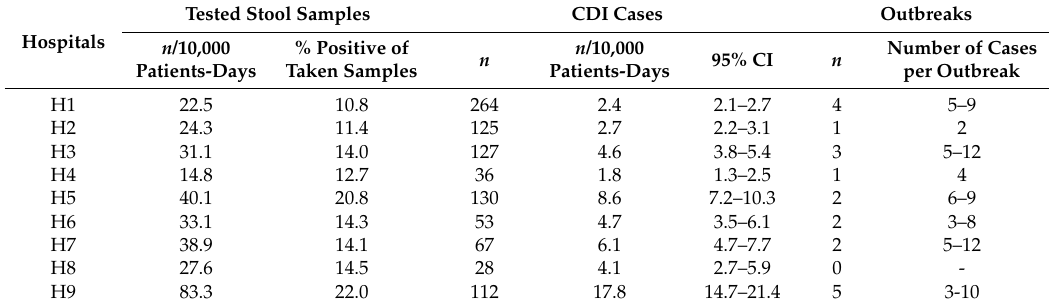
Table 2. Overall incidence of CDI in the nine hospitals of the Local Health Authority of Bologna during the study period (2010–2015). Hospitals are numbered in decreasing size